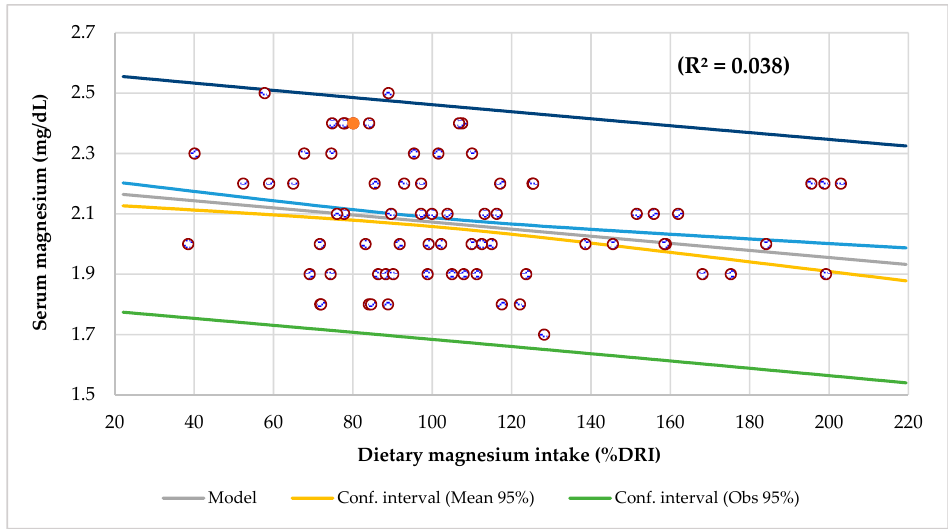
Figure 3. Regression of serum magnesium level (mg/dL) by dietary magnesium intake (%Dietary Reference Intake).